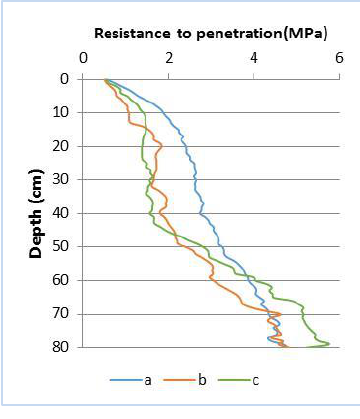
Figure 12. Penetrometric resistance of the tested soil: (a) average value for all plots; (b) Jasenovik locality—haplic vertisol (ochric), VR-ha-oh; (c) Malˇca locality—haplic vertisol, VR-ha-oh.